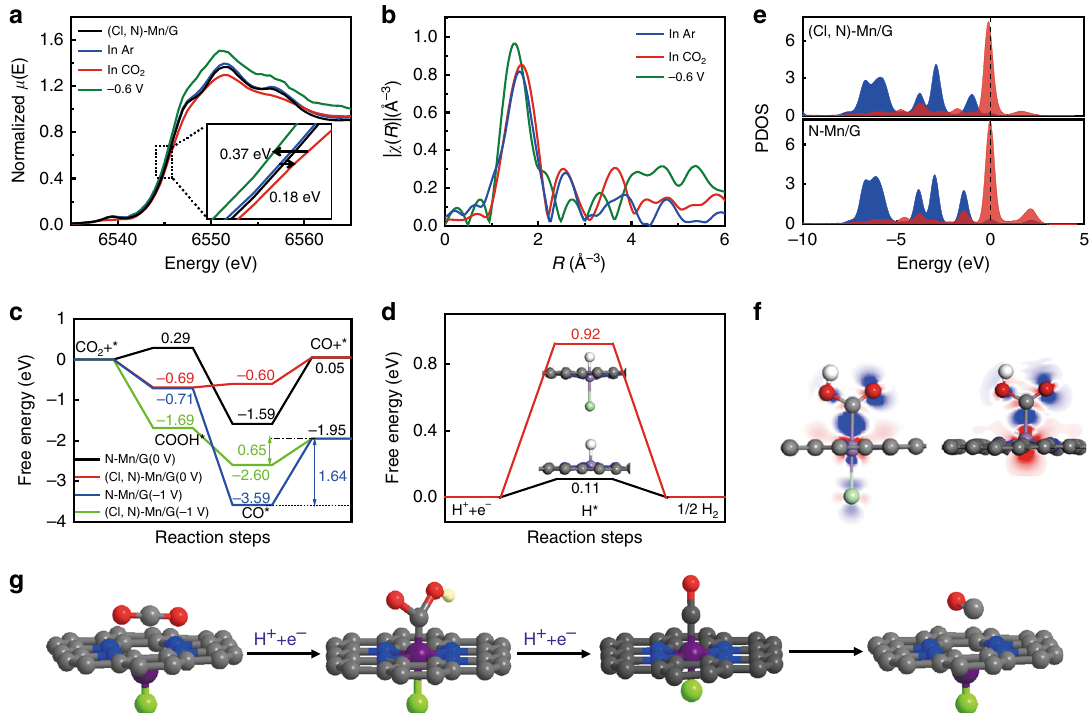
Fig. 4 In situ XAS experiment and DFT calculation. a Normalized XANES of (Cl, N)-Mn/G catalyst under various conditions (inset is the magni fi ed image). b Fourier transform magnitudes of EXAFS spectra of (Cl, N)-Mn/G. c Calculated free energy of CO 2 RR. d Calculated free energy of hydrogen adsorption. e Projected density of states (PDOS) of the COOH* 2p state (blue-shaded areas) and d-projected DOS of Mn (red-shaded areas) in the adsorption structures for (Cl, N)-Mn/G and N-Mn/G, respectively. f Electron density difference for COOH* adsorbed on (Cl, N)-Mn/G (left) and N-Mn/G (right). The blue and red denote the electron accumulation and electron depletion, respectively. g Structural evolution of the active site for (Cl, N)-Mn/G in electrochemical CO 2 RR (Mn: purple, Cl: green, N: blue, O: red, H: white and C: